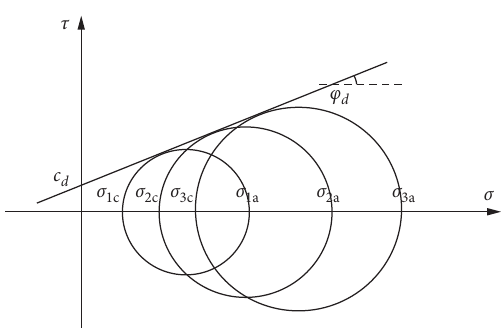
Figure 4: Diagram of Mohr–Column strength method.